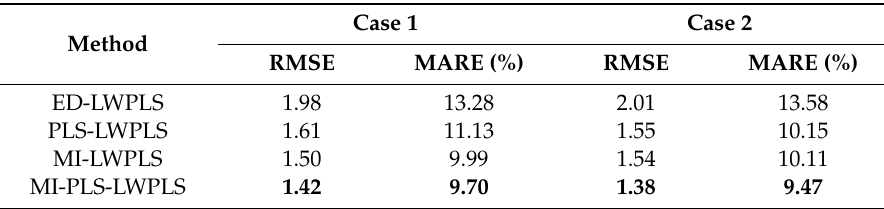
Table 1. Prediction errors of the four methods.